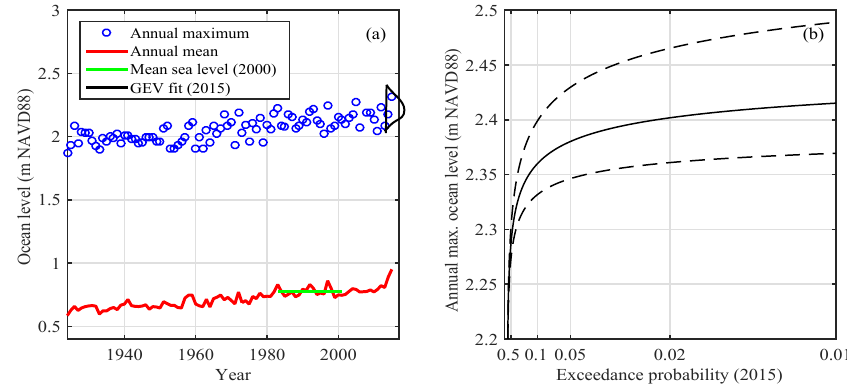
Figure A2. (a) Annual maximum ocean levels compared to annual mean ocean levels recorded at the La Jolla tide gage in CA, USA. The black line shows the fitted nonstationary GEV distribution during the year 2015. (b) Exceedance probabilities of extreme ocean levels derived from the 2015 GEV distribution. We do not show return periods on the x axis because exceedance probabilities are expected to change as mean sea level increases.